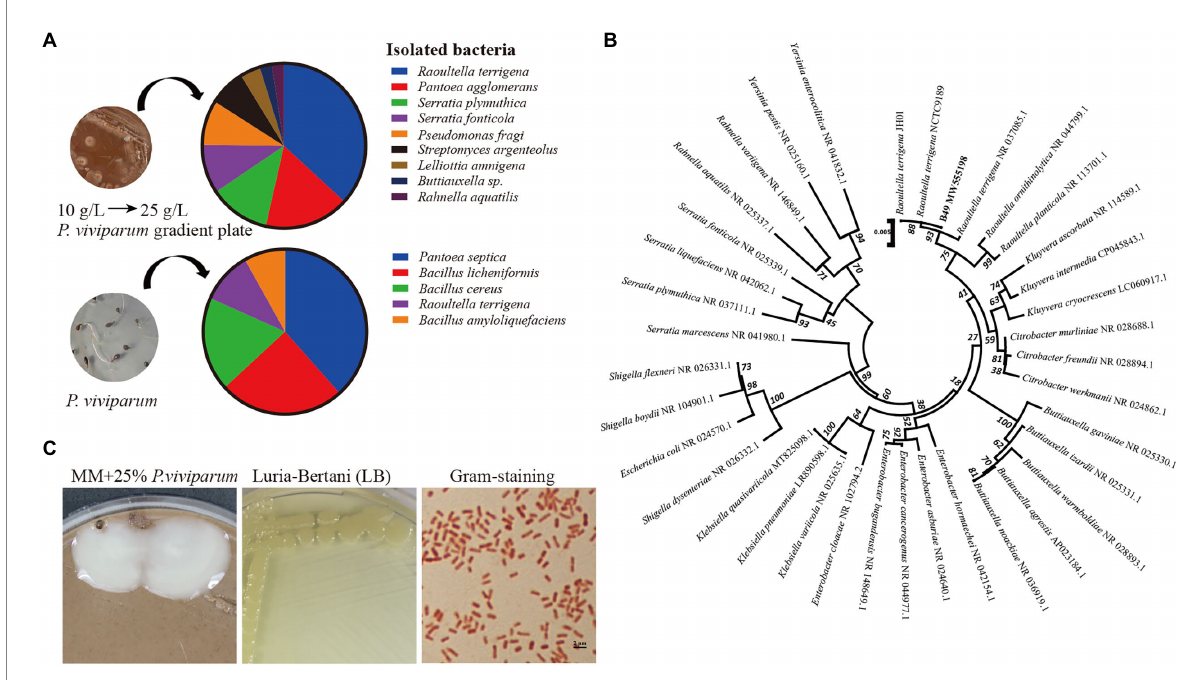
FIGURE 1 Characterization of the bacteria subsisting on Polygonum viviparum . (A) Identified bacterial species from the gut of Thitarodes xiaojinensis larvae on the mineral medium (MM) containing 10% P. viviparum root powder and from surface sterilized P. viviparum roots or seeds on LB medium (Lucia-Bertani) agar plates, (B) Phylogenetic tree of R. terrigena based on 16S rRNA by using the Neighbor-Joining method and 1,000 bootstrap replicates in MEGA 5.0 software, (C) Morphology of R. terrigena on MM containing 25% P. viviparum and LB after 24 h of culture, and a gram stain